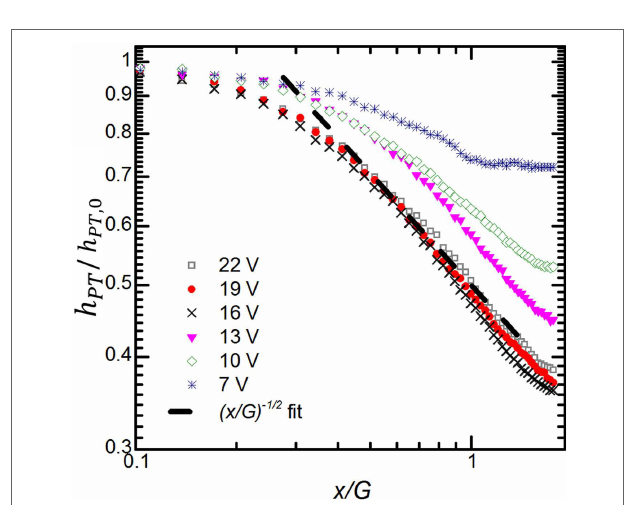
FIGURE 6 | Log–log plot of the normalized local convection coefficient as a function of the non-dimensional distance along the plate for various input voltages at a gap distance of G = 1cm . Equation 12 was used in the linear curve fit where C 1 was 0.5.